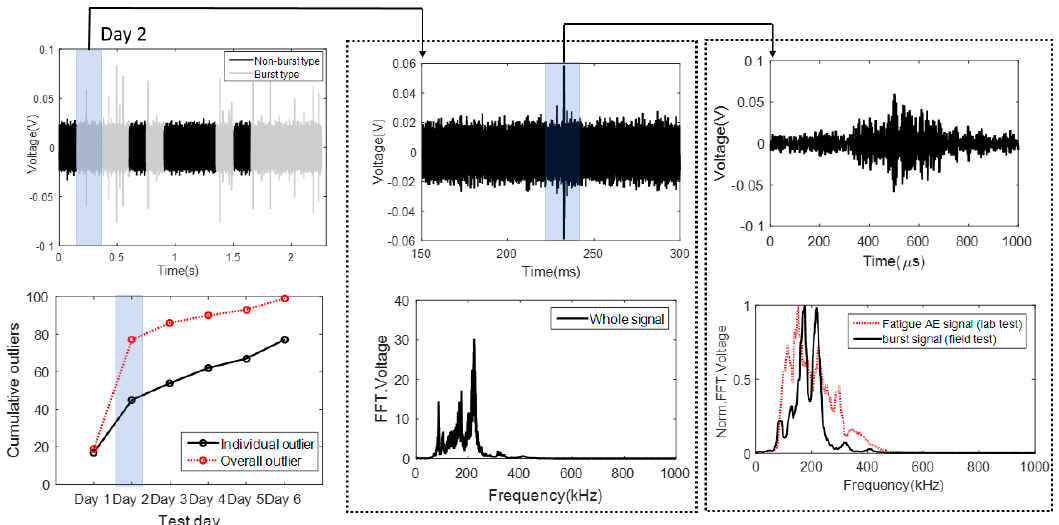
Figure 18. The burst signals detected in the test day 2 and their frequency spectra using the windowed time histories.